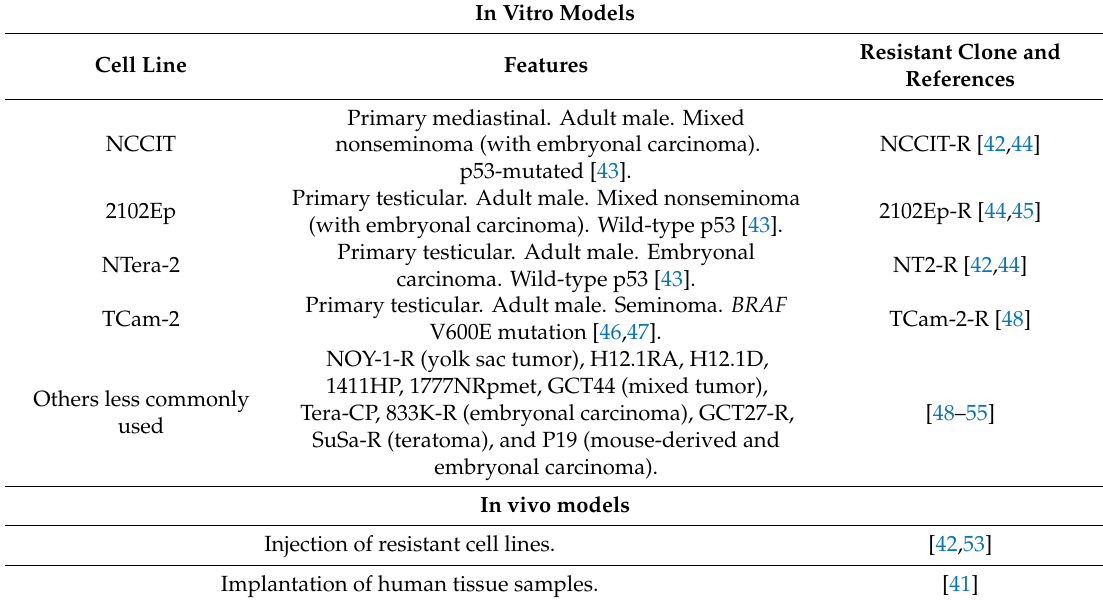
Table 1. In vitro and in vivo models for studying a cisplatin-resistant disease in (testicular) germ cell